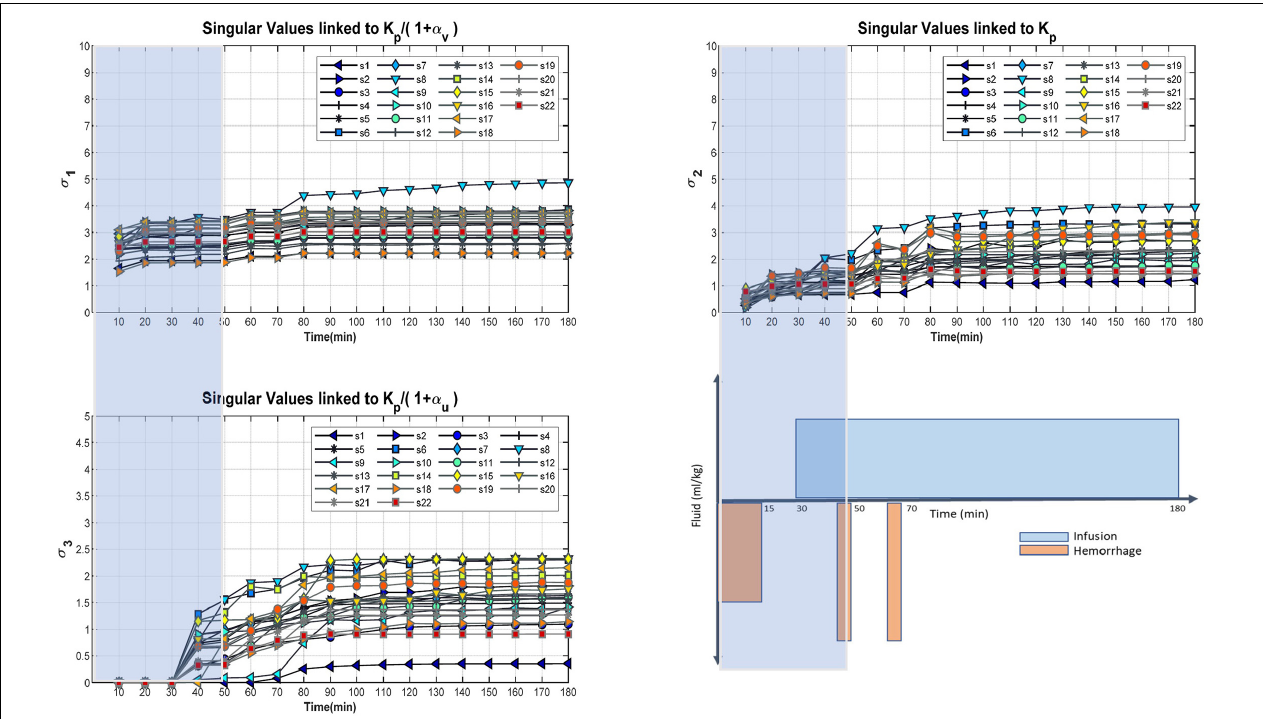
, K p , and K p 1 + α as determined by the approximation of the right singular matrix. Plot on the bottom right indicates FIGURE 2 | Entire cohort singular values for K p 1 + α v u the experimental protocol used for data collection depicting timing of fluid hemorrhage and infusion. X-axis of the singular value plots relates to the amount of experimental data under consideration, for example T c = 50 min corresponds to considering all data between 0 and 50 min. The calibration window of 0–50 min was selected because it was the largest time window that would allow for evaluation of model prediction in an independent data segment (i.e., 50–180 min) containing both infusion and hemorrhage while still having relatively large singular values for majority of subjects in the study. Overall, it can be concluded that α v is more identifiable than α u